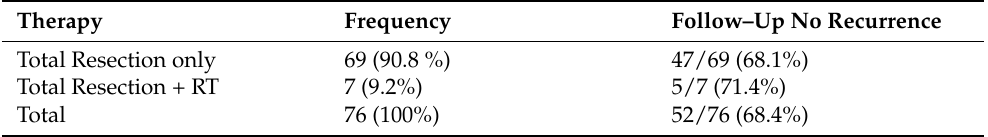
Table 2. Total Resection and Follow–Up Data: Total resection alone showed the best outcome when it came to therapy options. Regarding adjuvant therapy, the data are very limited.